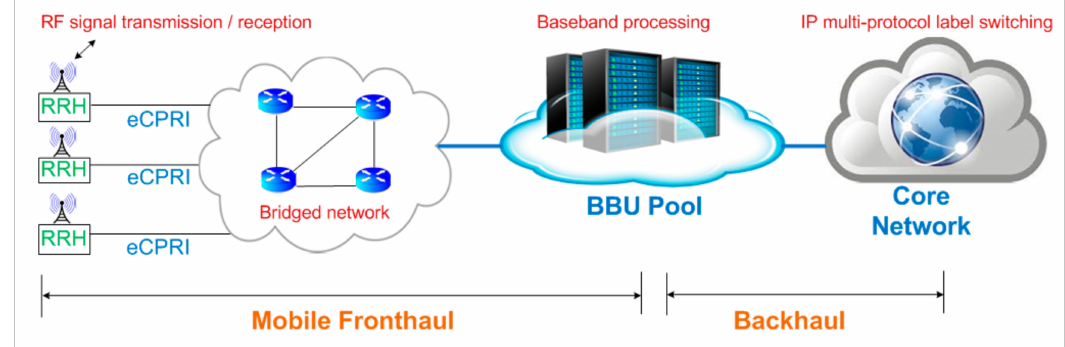
Figure 1. Cloud radio access networks (C-RANs) architecture for envisioned 5G cellular